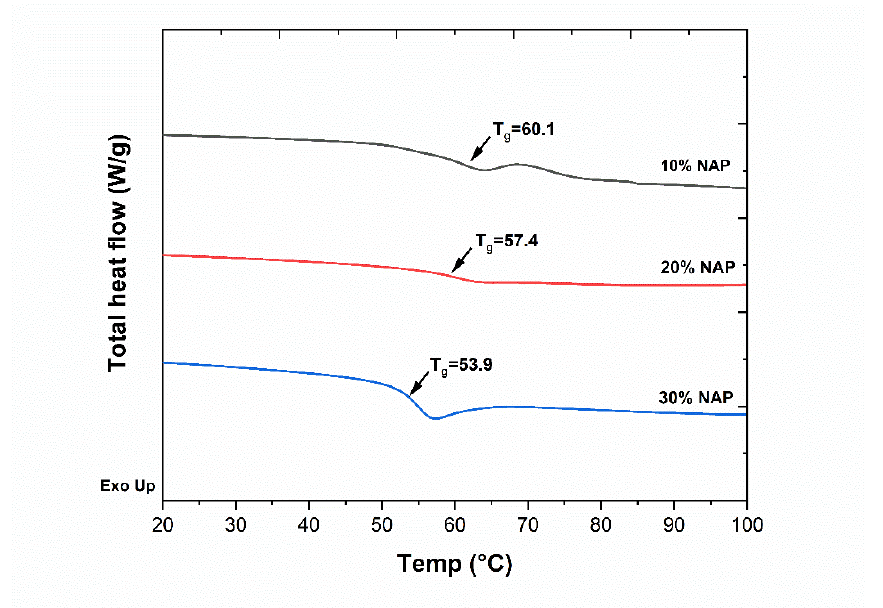
Figure 1. Differential scanning calorimetry (DSC) thermograms showing the decreasing glass transition temperatures ( T g ) of the filaments with increasing naproxen (NAP) content.